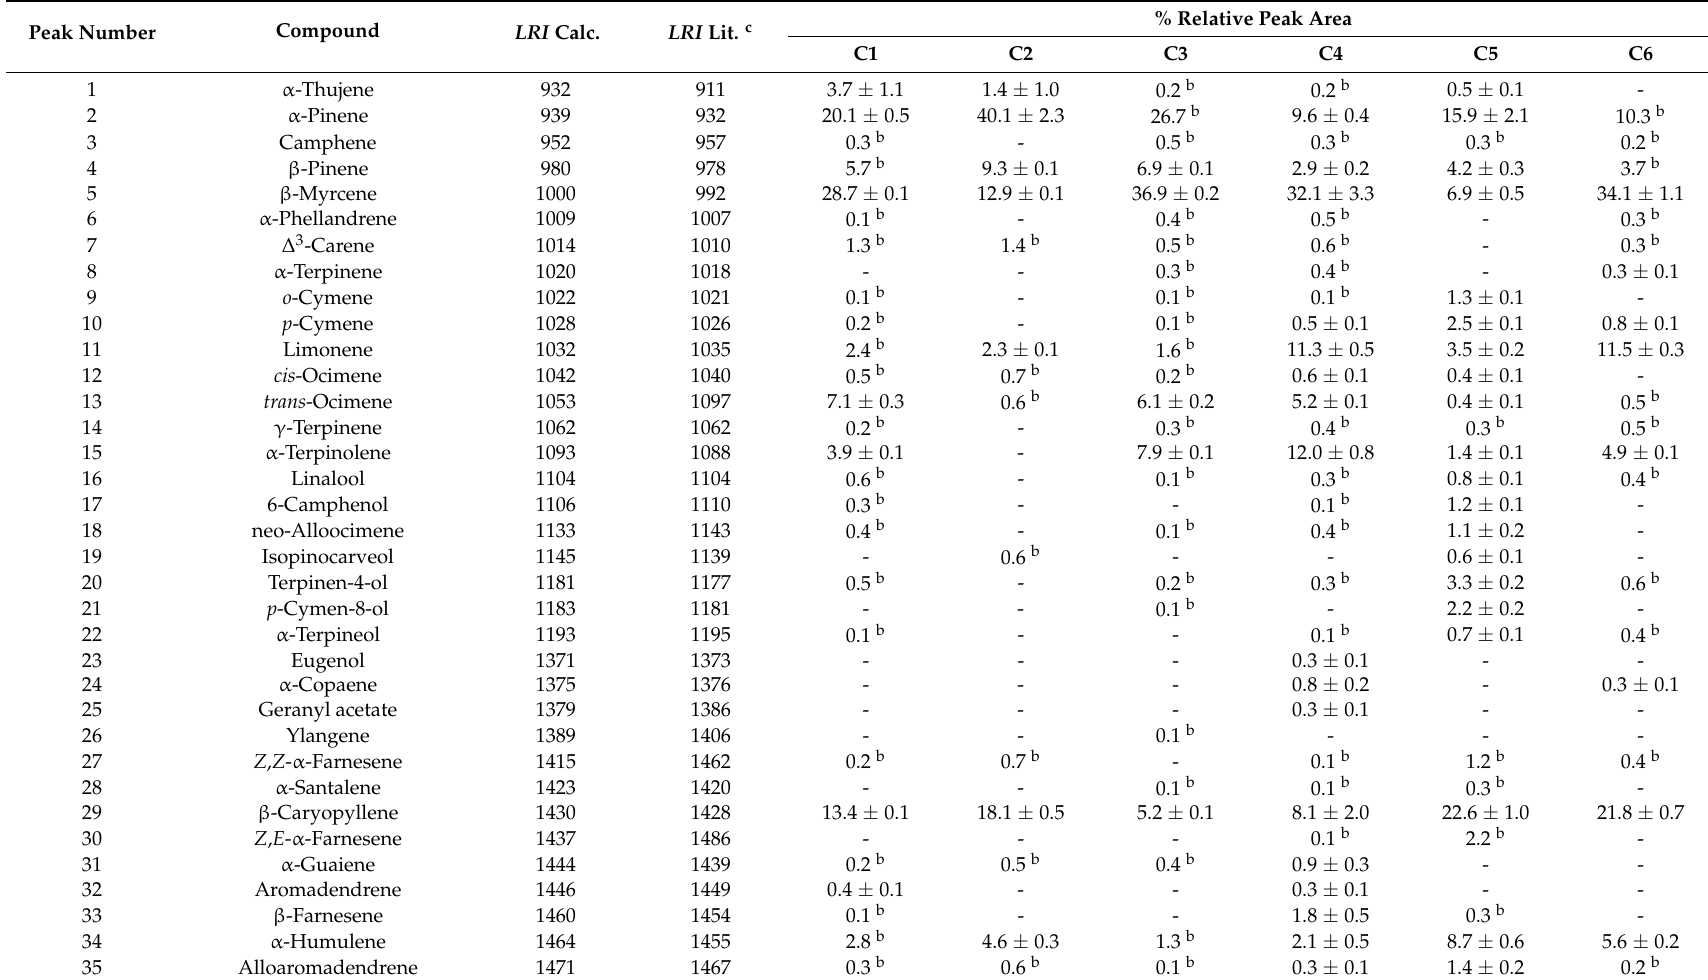
Table 4. Semi-quantitative data (% relative peak area values) for volatile compounds from hemp inflorescences a